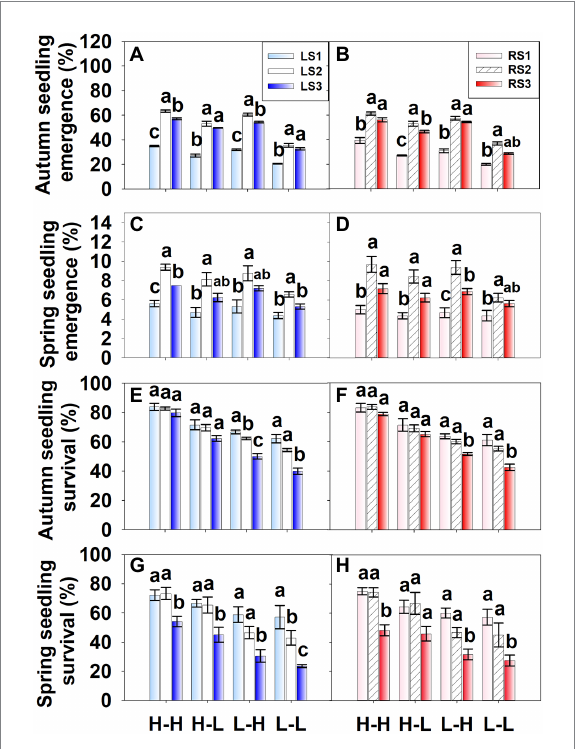
FIGURE 7 Seedling emergence percentages (from seeds separated from spikelets) and survival percentages of Aegilops tauschii in field plots. H-H, added fertilizer, watered regularly; H-L, added fertilizer, natural moisture; L-H, no fertilizer, watered regularly; L-L, no fertilizer, natural moisture; LS, spikelet type Left; RS, spikelet type Right. Numbers 1, 2 or 3 following LS and RS indicate different seed groups. Seed groups within a soil condition for L and R with different letters are significantly different (Tukey’s HSD, p =